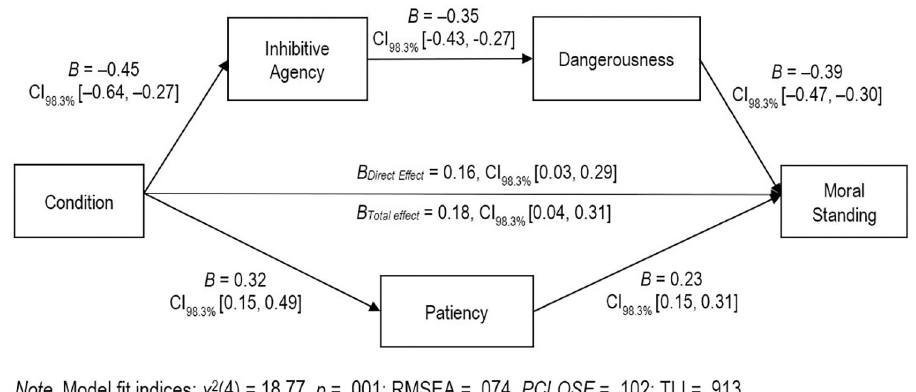
Fig 6. Dual path model of using the defense of mental impairment on moral standing. Path values are expressed in unstandardized coefficients.